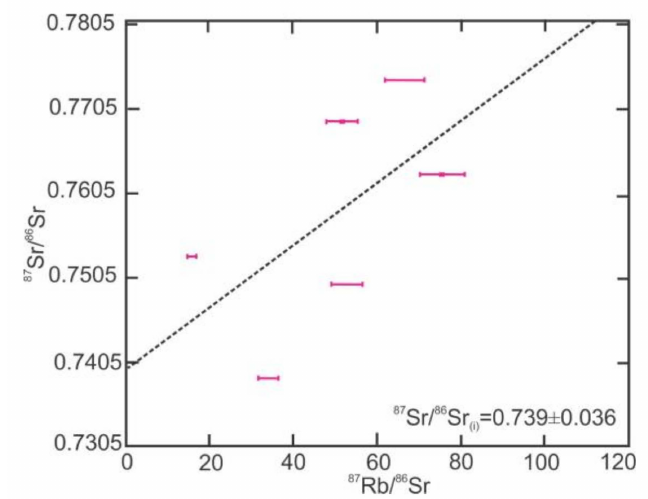
Figure 7. 87 Sr/ 86 Sr vs. 87 Rb/ 86 Sr diagram. The Ebrahim-Attar beryl sample plots show an intercept of 87 Sr/ 86 Sr (i) = 0.739 ± 0.036. The external error for 87 Sr/ 86 Sr ranges from 0.000012 to 0.000019, which is calculated based on 1SE and 1SD of the standard error (NIST-SRM